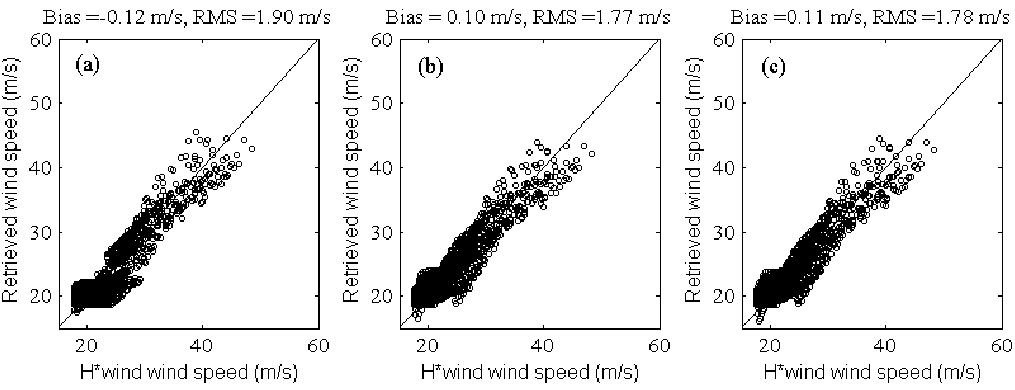
Figure 4. H*wind analysis data versus the retrieved wind speeds over hurricane Rita (2005): ( a ) using the Ellison model and the Reynolds weekly analysis data; ( b ) using the Klein-Swift model and the Reynolds weekly analysis data; and ( c ) using the Klein-Swift model and a fixed SST (29 °C). Table 2. Errors between H*wind analysis data and the retrieved wind speeds using the Klein-swift model with different fixed sea surface temperatures.